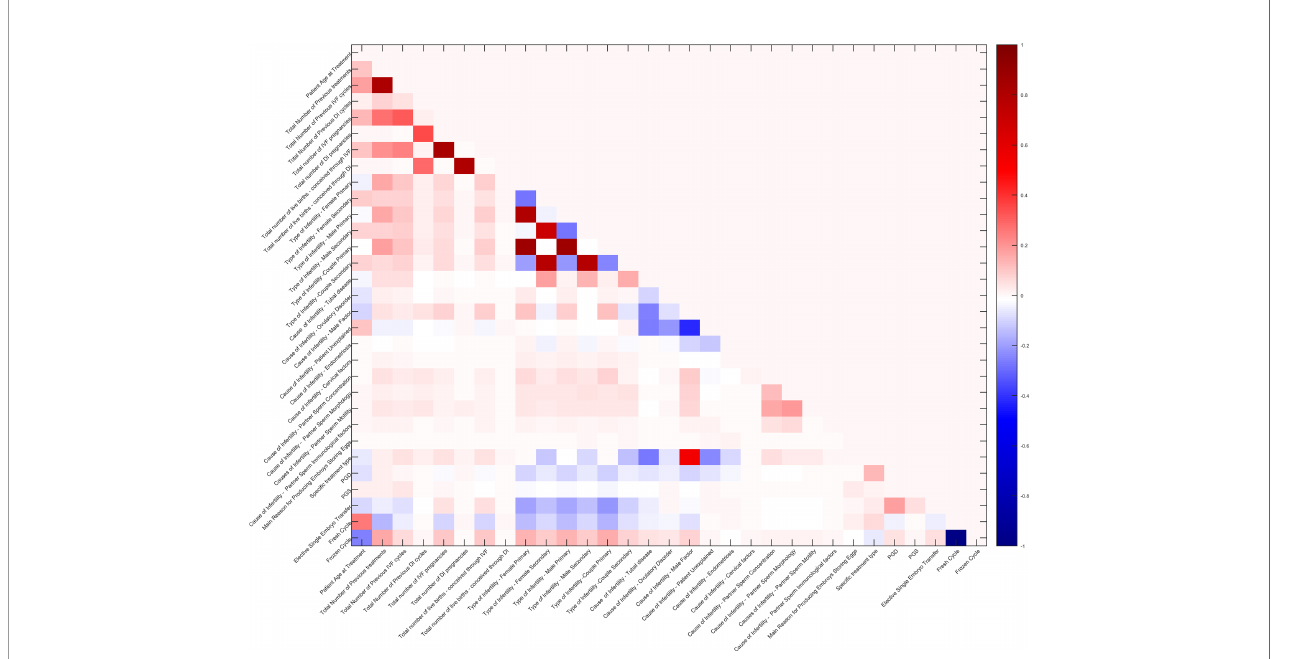
FIGURE 2 | Correlation matrix of 31 features. The redder grids indicate higher positive correlation values of feature pairs, the bluer ones indicate higher negative correlation values, and the white ones indicate no